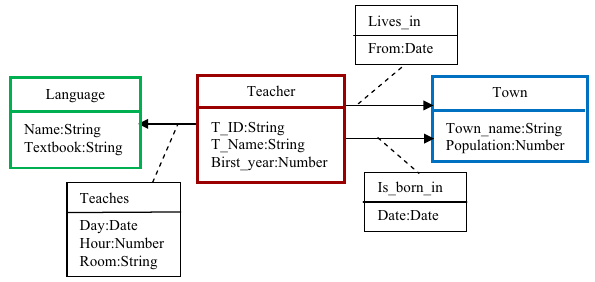
Fig. 6 Graph database schema with properties